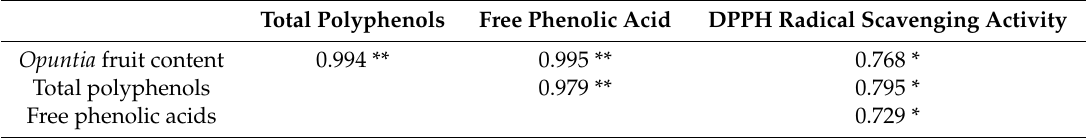
Table3. Pearson’scorrelationcoe ffi cientsforgluten-freepastasupplementedwith Opuntia fruitaddition. Total Polyphenols Free Phenolic Acid DPPH Radical Scavenging Activity Opuntia fruit content 0.994 ** Total